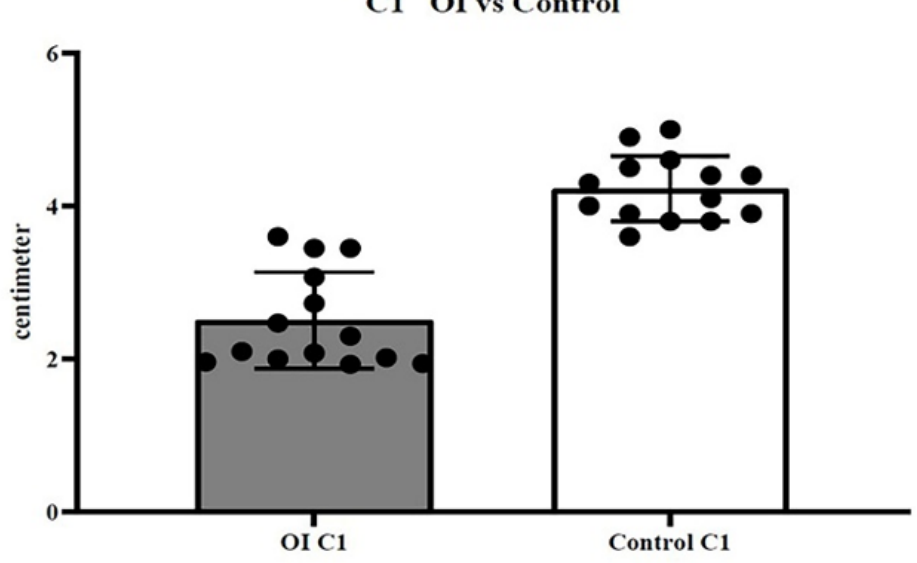
Figure 3. First dataset (C1 sick population vs. C1 healthy population); t -test showed a p -value < 0.0001.